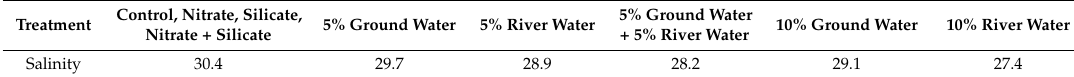
Table 2. Salinities of each